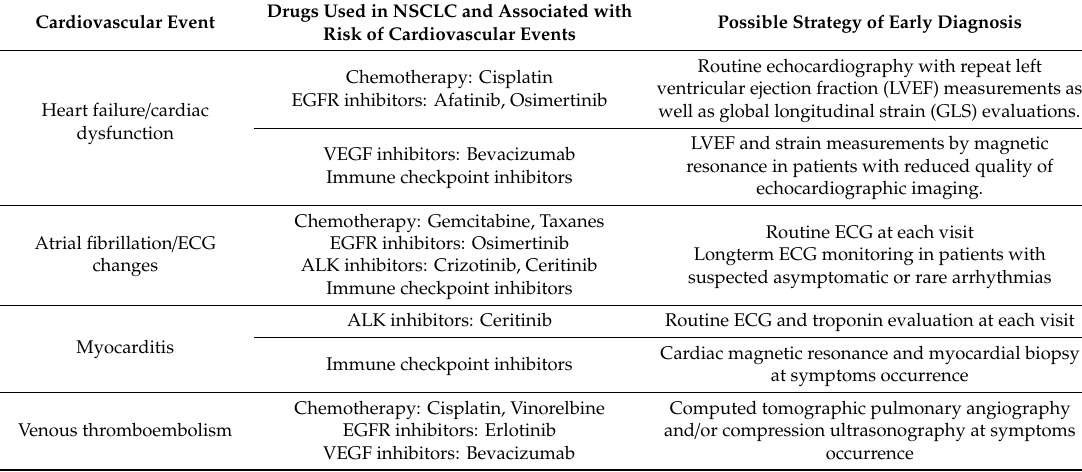
Table 2. Cardiovascular events induced by NSCLC therapy and possible strategy of early diagnosis. Cardiovascular